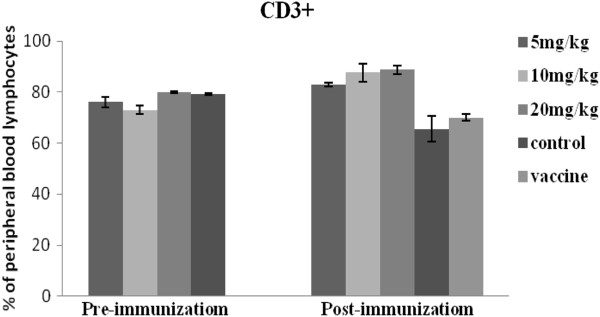
Illustrates the percentages of CD3+ lymphocyte expression before and after immunization in vivo. Prior to immunization there was no difference in the percentile level of CD3+ for APS treatment groups and control groups. After immunization the CD3+ percentage for the APS groups was higher than for the corresponding controls.